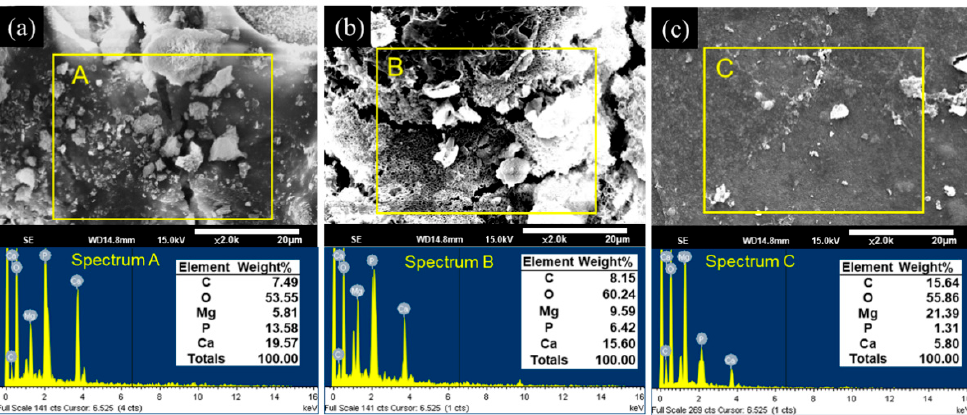
Figure 6. SEM observations and EDS point spectrum analysis of the corroded surfaces after 30 days of immersion for ( a ) ZX31; ( b ) ZX31(CHI/LGA) 2 and ( c ) ZX31(CHI/LGA) 7 .